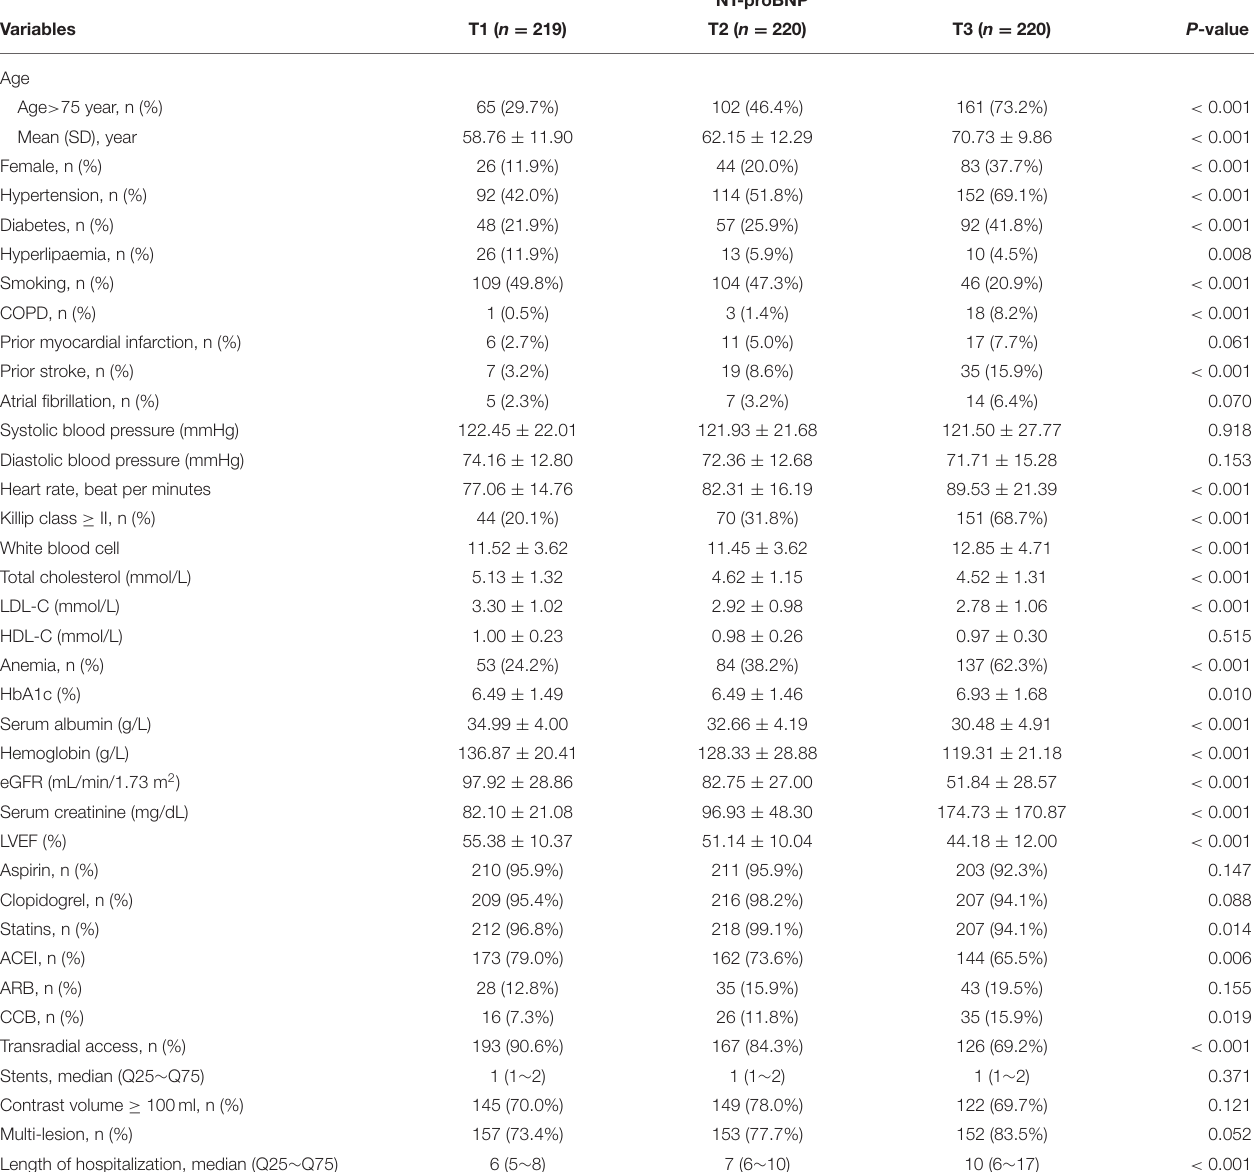
TABLE 1 | Baseline characteristics according to NT-proBNP